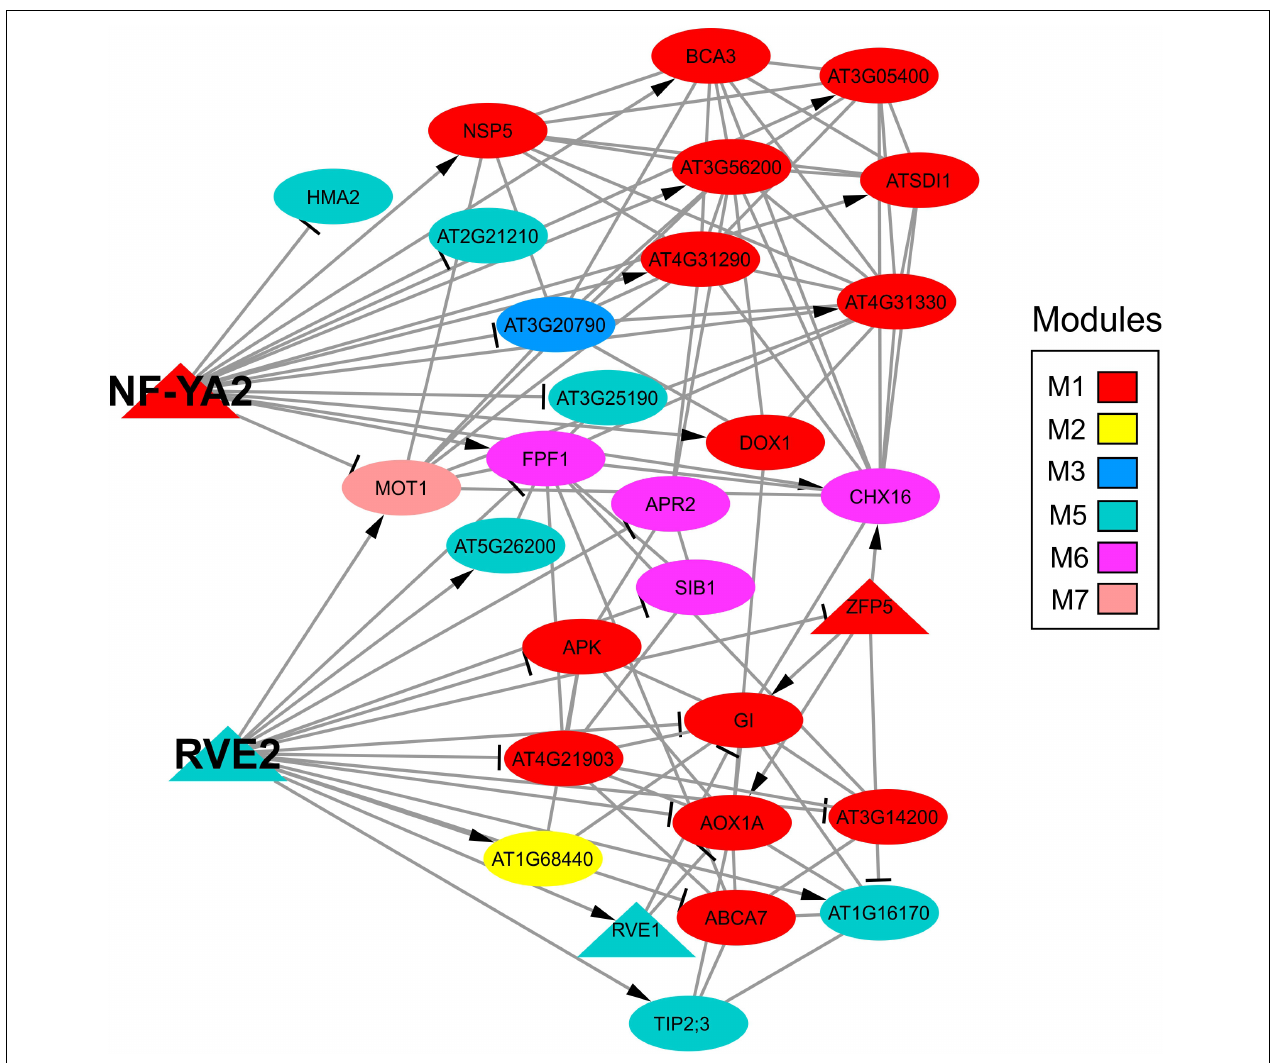
FIGURE 8 | Subnetwork of two TFs (NF-YA2 and RVE2) identified as intermodular hub genes of the sulfate gene co-expression network. The color code indicates the co-expression module to which each gene belongs according to the sulfate co-expression network presented in Figure 5 . The arrows or lines at the end of an edge indicate positive or negative correlations, respectively. The shape of each specific node is related to TFs (triangle) or targets (circle) and the size depends on the number of connections of each node in such a way that nodes with higher size are the most connected genes in the